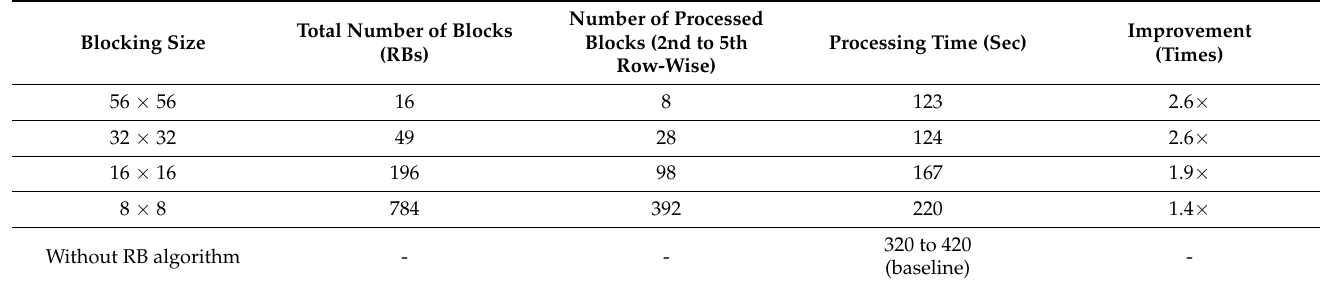
Table 2. Timing estimation of different region’s blocking size of X-ray image 224 ×